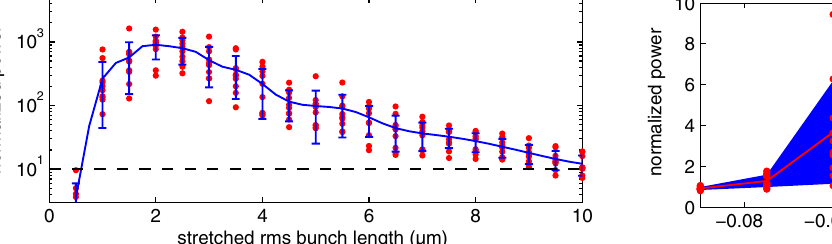
FIG. 4. Normalized power (log scale) for a stretched bunch of FIG. 5. Normalized power (linear scale) for a stretched (cid:1) ¼ 0 : 5 (cid:10) m , 1% energy chirp over (cid:1) , and a slice- initially (cid:1) 2 : 5 (cid:10) m , Q ¼ 5 pC bunch, for a varying linear undulator taper. z z ¼ 0 : 5% . The solid line is the average over energy spread of ^ (cid:1) As before, dots mark individual runs and the solid line is the (cid:2);s 10 runs and the error bars mark 1 standard deviation of the shot-to- average over different shot-noise seeds. The blue area indicates 1 shot power fluctuation. FEL performance is significantly en- standard deviation of the spread in hanced compared to the initial bunch length. Dots represent individualruns ofdifferent shot-noise seeds to illustrate the spread in power, which originates from the self-amplified spontaneous emission FEL starting from noise. The rms variation in pulse energy relates to the number of modes M in the FEL pulse and scales with M (cid:5) 1 = 2 [33]. As the bunch length is comparably short, only a few modes are supported, leading to large shot-to-shot fluctuations.